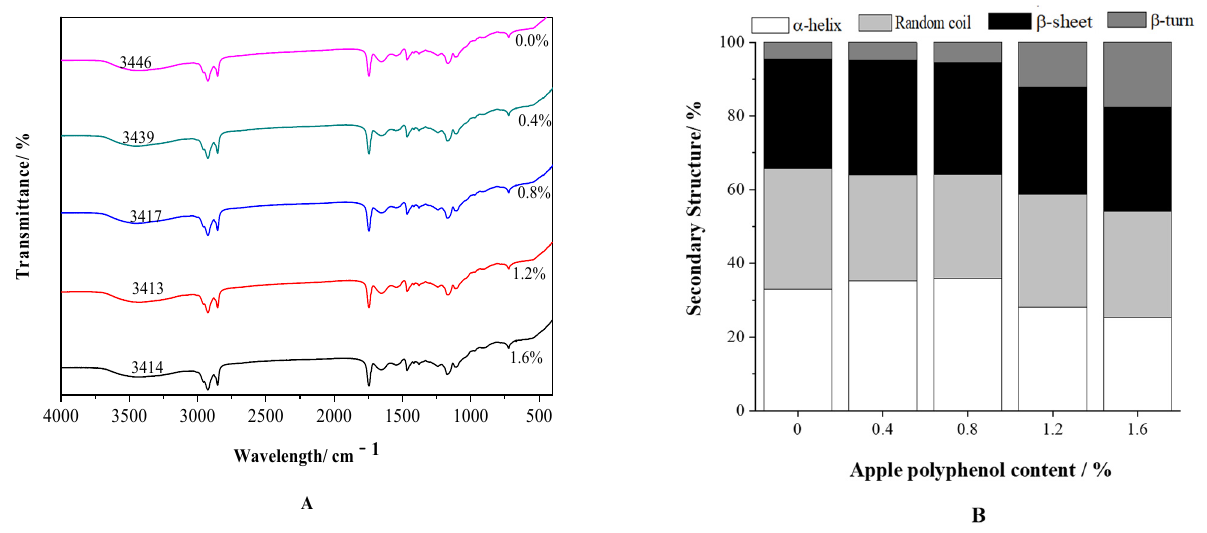
Figure 4. ( A ) Fourier transform infrared (FT-IR) spectra of processed cheese samples with added apple polyphenols; ( B ) Effect of apple polyphenol addition on the protein secondary structure of processed cheese.